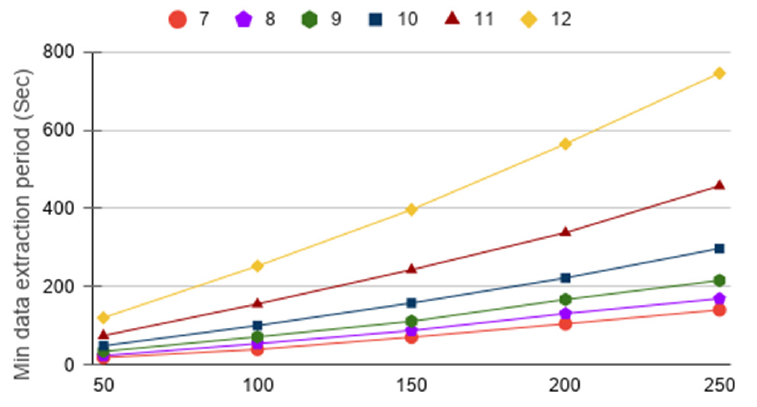
Figure 16. Minimum data extraction period for a different number of nodes at different Spreading Factors (SFs).